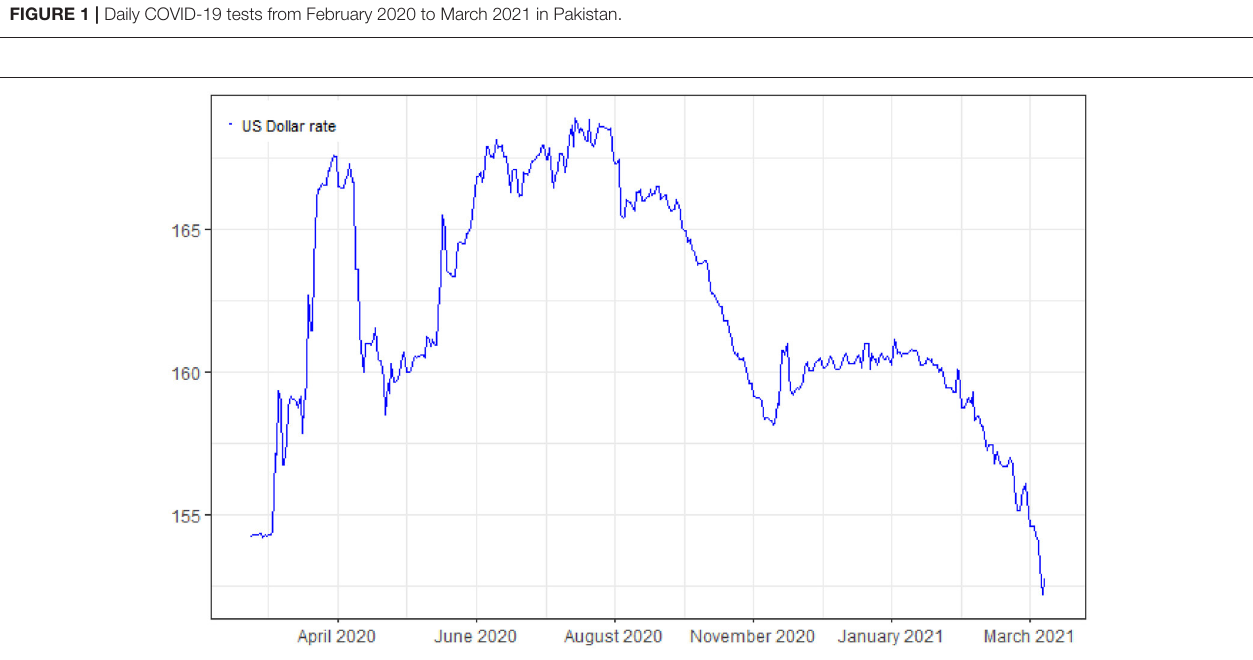
FIGURE 2 | Shows daily US-dollar exchange rate from February 2020 to March 2021 in